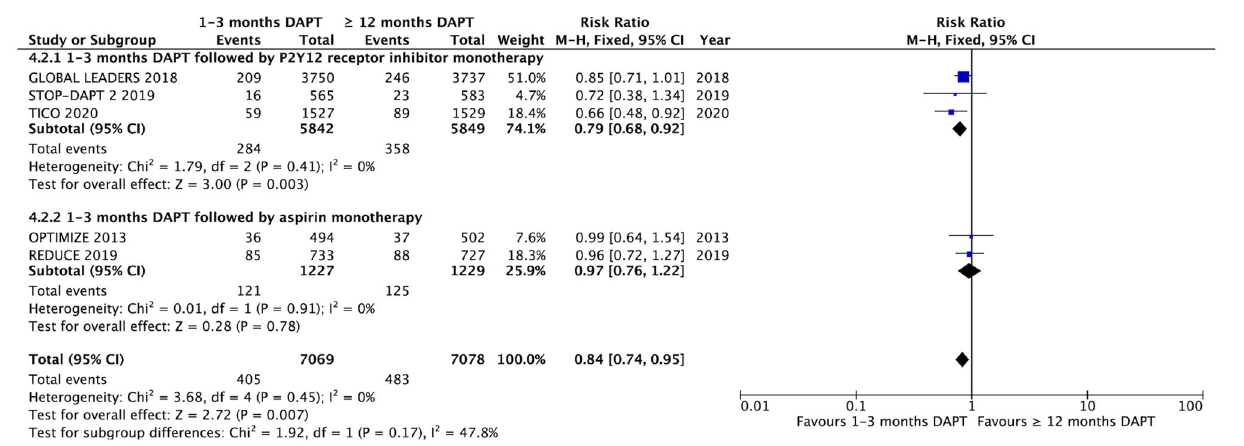
FIGURE 4 | Comparison of complication endpoints of NACCE and subgroup analysis between groups with short-term and long-term